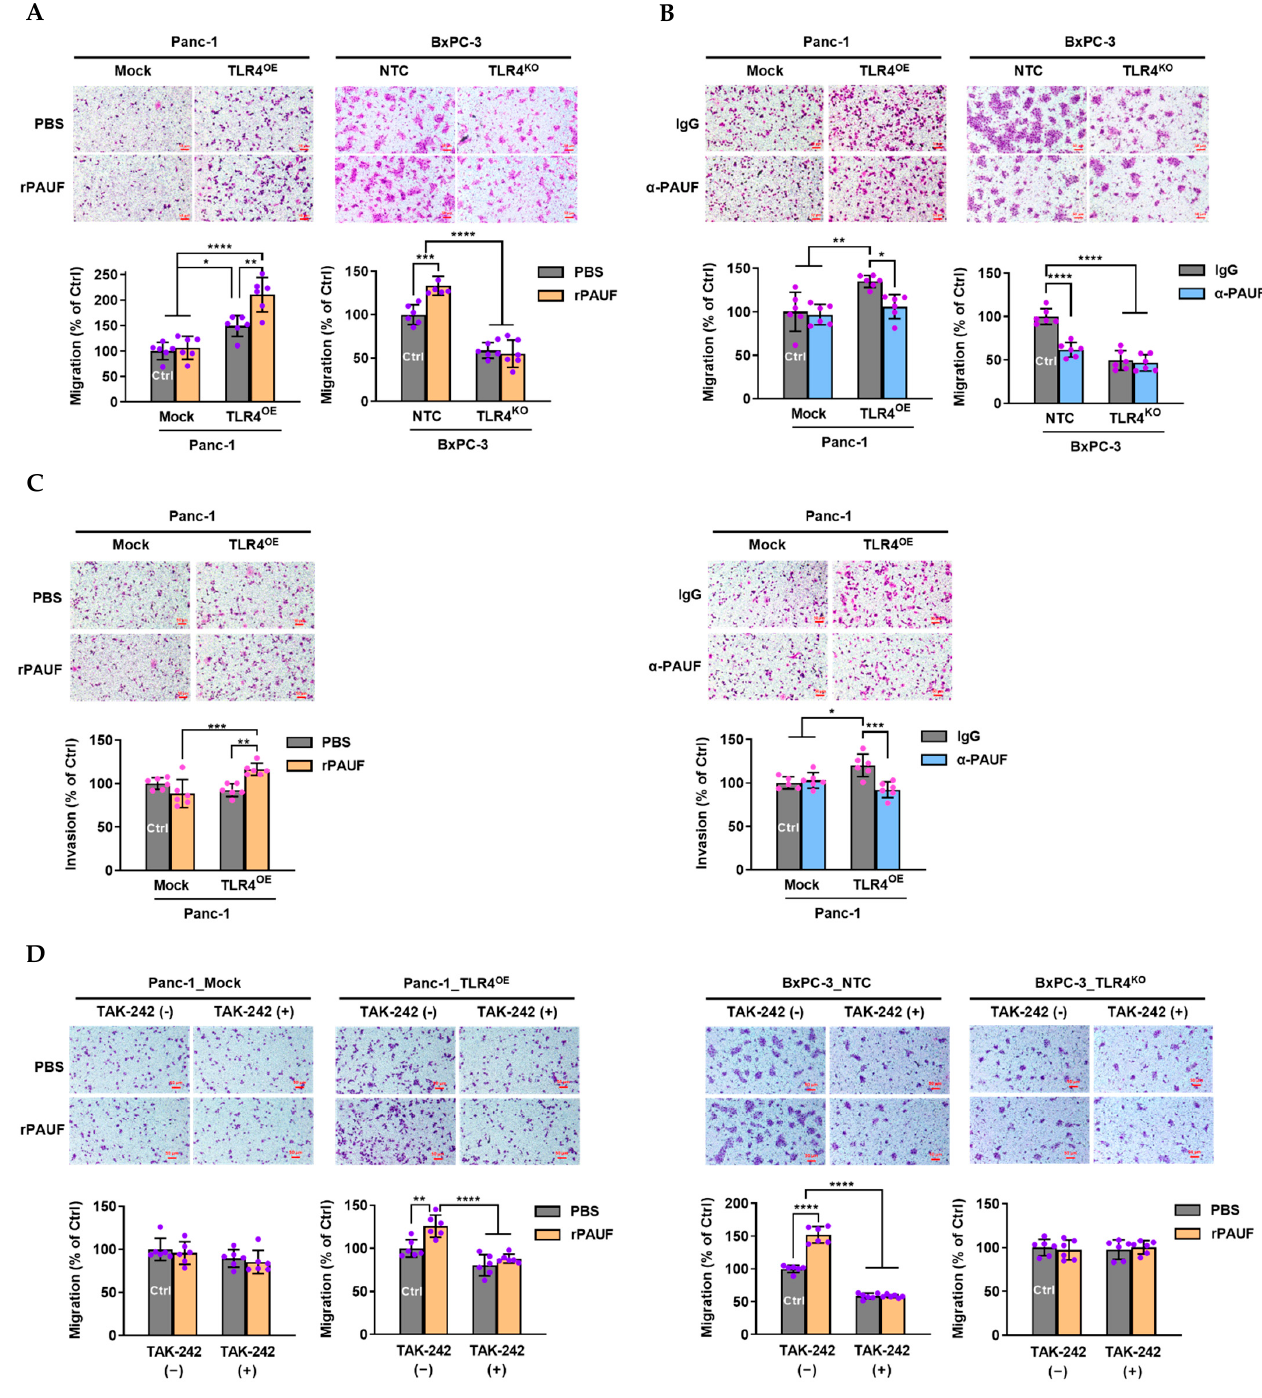
Figure 4. PAUF’s impacts on pancreatic cancer cell migration and invasion are exclusively dependent on TLR4. Migration of Panc-1_Mock and Panc-1_TLR4 OE were estimated using transwell assays after treatment of ( A ) recombinant PAUF (rPAUF, 0.5 µg/mL) or ( B ) PAUF antibody ( α -PAUF, 20 µg/ml) for 24 h. ( C ) Invasion of Panc-1_Mock and Panc-1_TLR4 OE were determined using transwell assays after treatment of rPAUF (0.5 µg/mL) or α -PAUF (20 µg/ml) for 24 h. ( D ) Migration of pan- creatic cancer cells induced by rPAUF in presence or absence of TAK-242, a TLR4 inhibitor. Data are represented as mean ± SD from multiple replicates. * p < 0.05, ** p < 0.01, *** p < 0.001, **** p < 0.0001 were obtained from two-way ANOVA and post-hoc multiple comparisons with Bonferroni correc- tion. Scale bars, 50 µm.